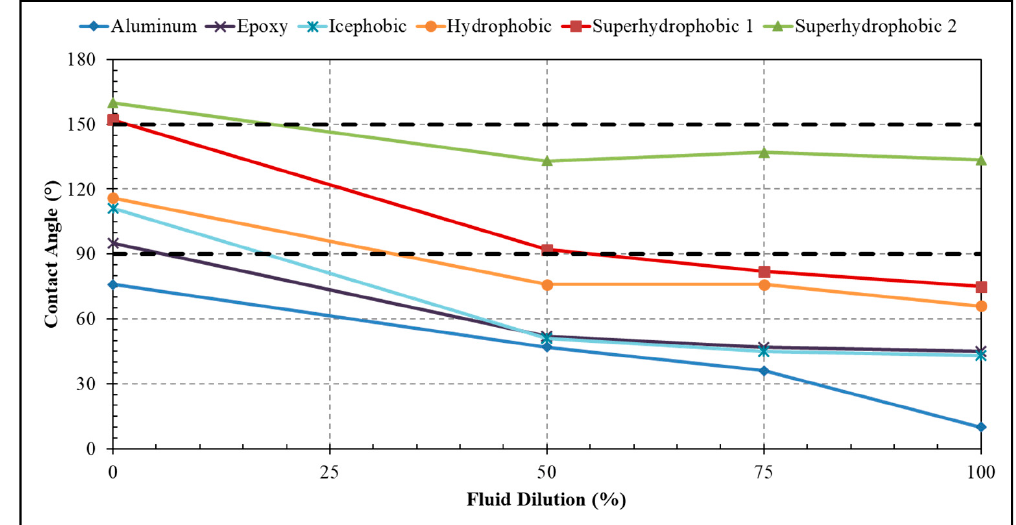
Figure 6. Contact angle of Fluid B with each set of surfaces as a function of its dilution (% V / V ).